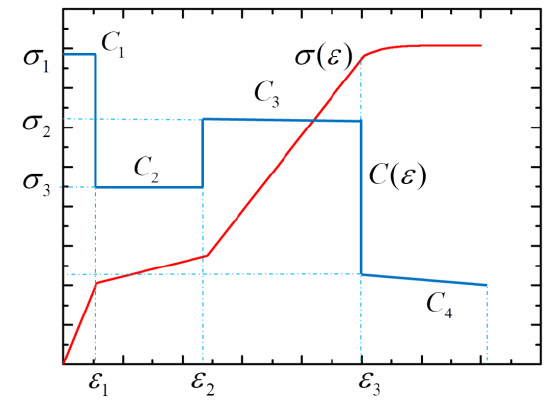
Figure 8. The stress – strain response and its induced stress wave velocity.